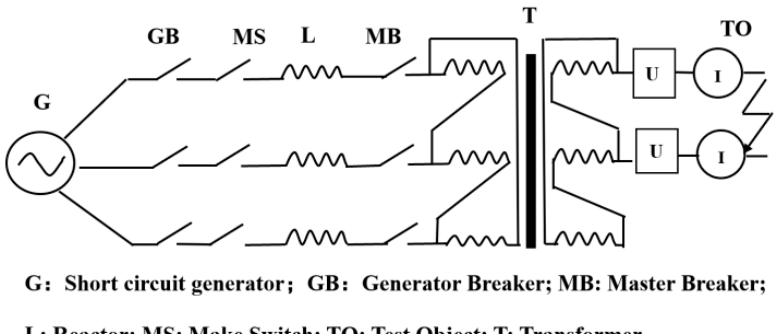
Figure 15. Experimental circuit.